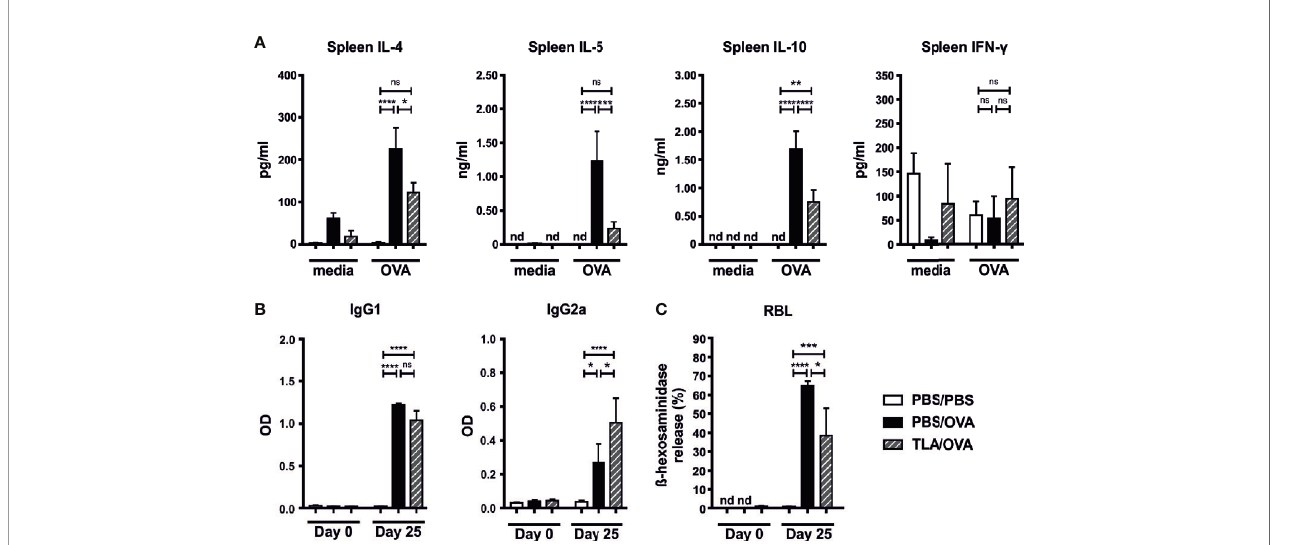
FIGURE 3 | TLA reduces systemic IL-4 and serum IgE-levels in a co-application model. (A) Levels of IL-4, IL-5, IL-10, and IFN- g after medium and ovalbumin (OVA) restimulation of spleen cells from mice treated as in Figure 2A . (B) Levels of OVA-speci fi c antibodies IgG1 and IgG2a in serum collected at the beginning and at the end of the experiment. (C) Release of b -hexosaminidase by rat basophil leukemia (RBL) cells. Graphs show results from 1 experiment with 5 mice per group (PBS/ PBS) or 1 representative experiment from 2 independent experiments with 5 mice per group (PBS/OVA and TLA/OVA). Error bars show mean ± SEM. TLA , tachyzoites lysate antigen; OD , optical density; nd , not detectable; ns , not signi fi cant; *P < 0.05; ** P < 0.01; *** P < 0.001; ****P <